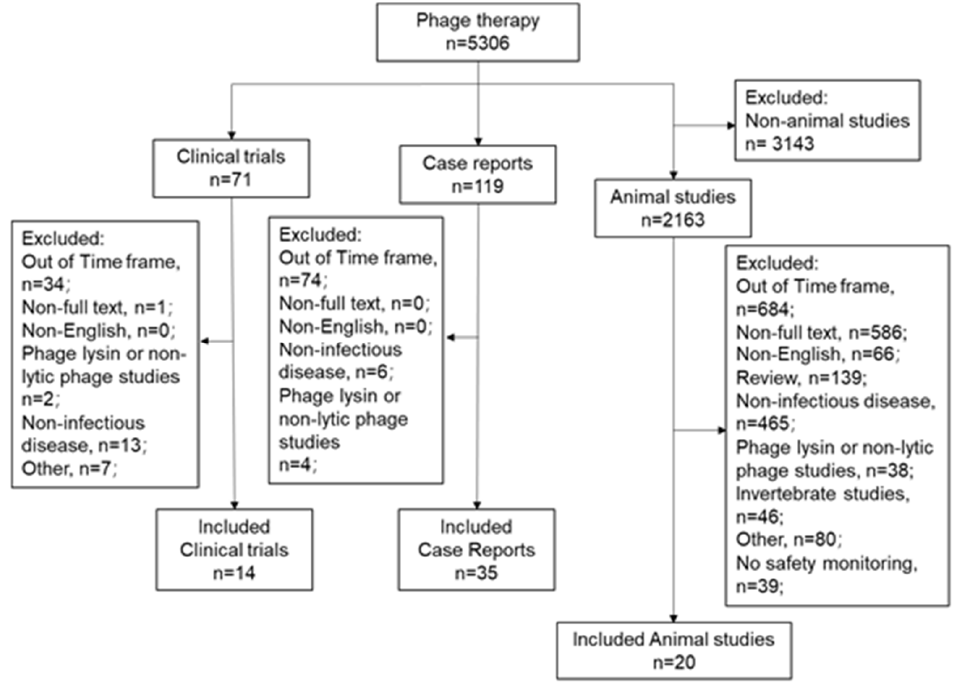
Figure 1. Search strategy.